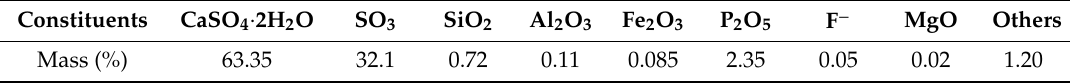
Table 1. Phosphogypsum chemical properties.